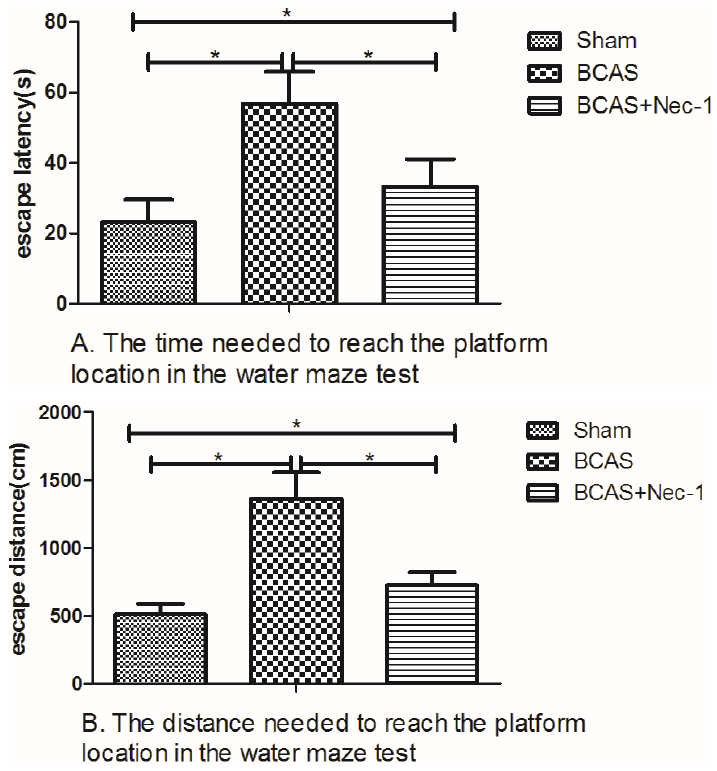
Figure 5. Nec ‐ 1 improved cognitive function in the mice. ( A ) The time and distance needed to reach the platform location in the water maze test. Data showed that the time in the BCAS group was longer than in the BCAS with Nec ‐ 1 group (* p < 0.05); ( B ) The distance needed to reach the platform location in the water maze test. Data showed that the distance in the BCAS group was longer than in the BCAS with Nec ‐ 1 group (* p < 0.05).